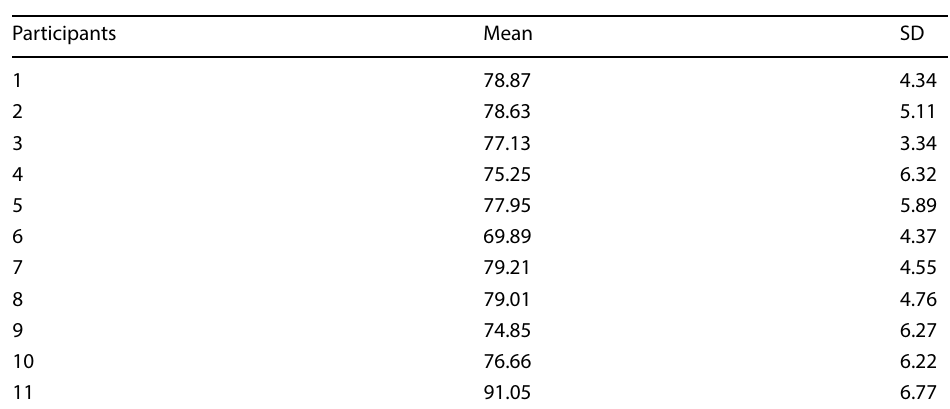
Table 3 Descriptive statistics of